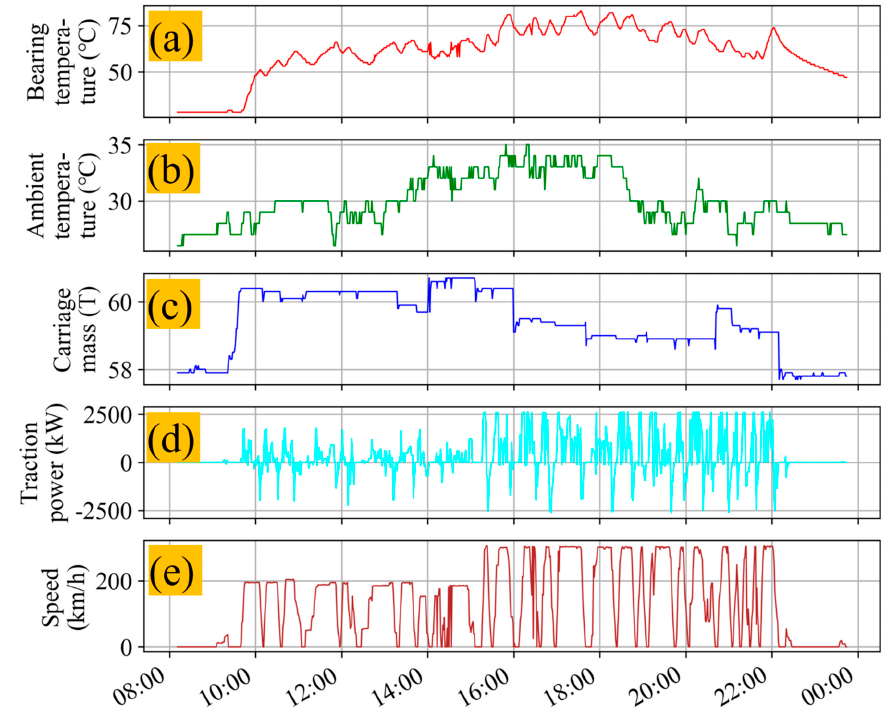
Figure 4. Graphs of ( a ) axle box bearing temperature, ( b ) ambient temperature, ( c ) carriage mass, ( d ) motor traction power, and ( e ) train speed collected over one day.